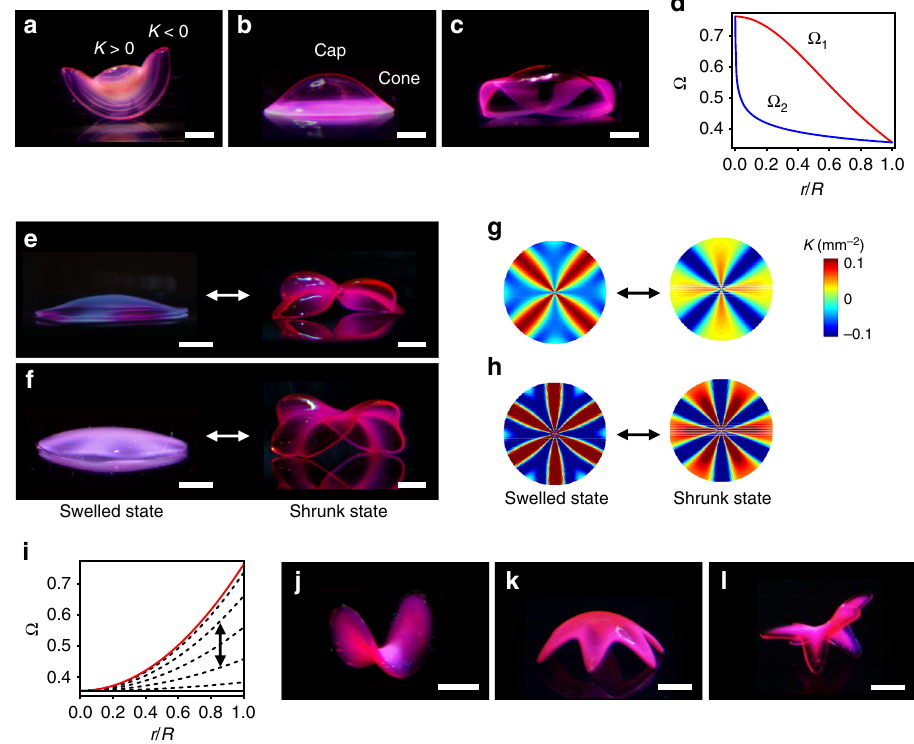
Fig. 3 Nonaxisymmetric 3D structures with morphological diversity. a – c Hybrid 3D structures with radially ( a , b ) and azimuthally ( c ) combined Ω . d Ω used to create the 3D structures in c : Ω 1 (red line), Ω 2 (blue line). e , f 3D structures with alternating K > 0 and K < 0 and 4 ( e ) and 6 ( f ) nodes along θ . g , h Theoretically calculated Gaussian curvature K of the structures with 4 ( g ) and 6 ( h ) nodes shown in e , f at the swelled (left) and shrunk (right) states. i Ω used to form the structures in e , f . The red line, black line, and dashed black lines indicate Ω at θ = 0 and ( l π )/ L (maximum Ω ), θ = (2 l – 1) π /2 L (minimum Ω ), and θ between the maximum and minimum of Ω , where l and L are constants. l is a positive integer. j Elongated elliptical saddle structure with an aspect ratio of 2 ( b = 0.5). k Spherical cap with 6 legs ( b = 0.5, L = 3). l Saddle-like structure with 6 legs ( b = 0.5, L = 3). Scale bars, 2 mm in a – c ; 5 mm (left), 2 mm (right) in e , f ; 2 mm in j – excess cone (Supplementary Figure 9) 45,46 with c ( θ ) = c 0 cos 2 ( L θ ),